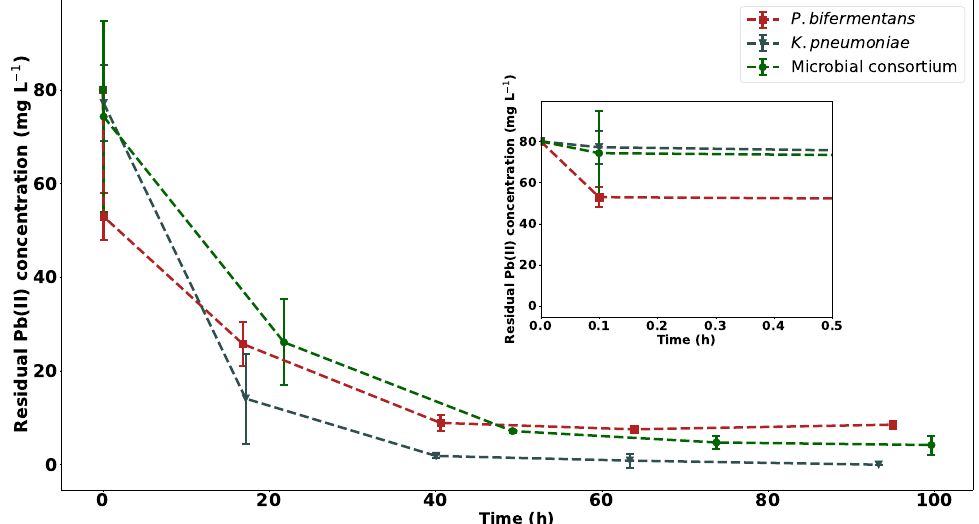
Figure 3. The residual Pb(II) concentration change over time for each experiment over 100 h with n = 3, with an inset graph depicting the initial 30 min of the